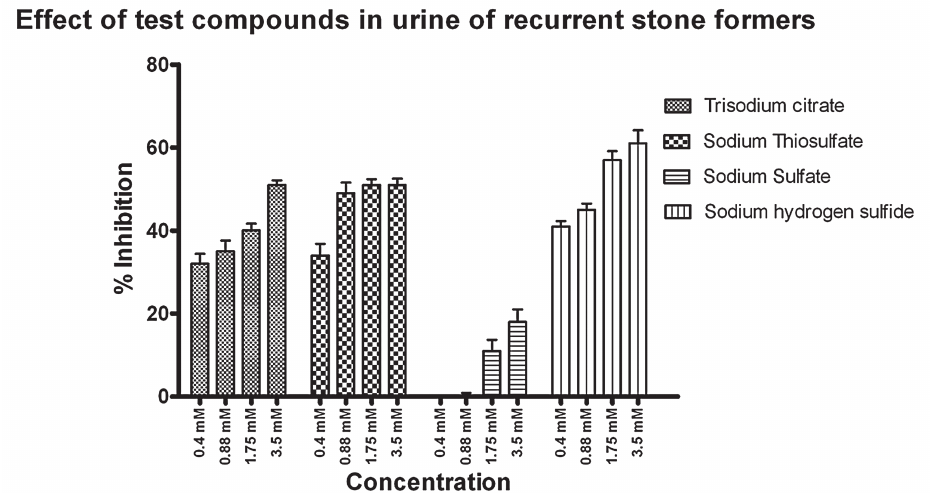
Figure 5 - Effect of test compounds on kinetics of calcium oxalate in urine of recurrent stone formers. Data are mean±S.D. of three observations.